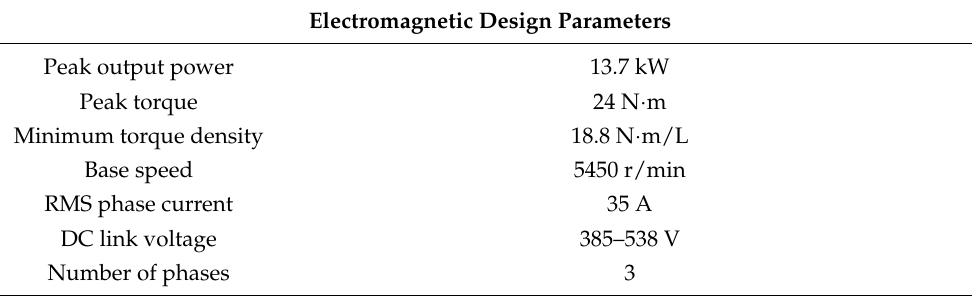
Table 1. Main design specifications of an